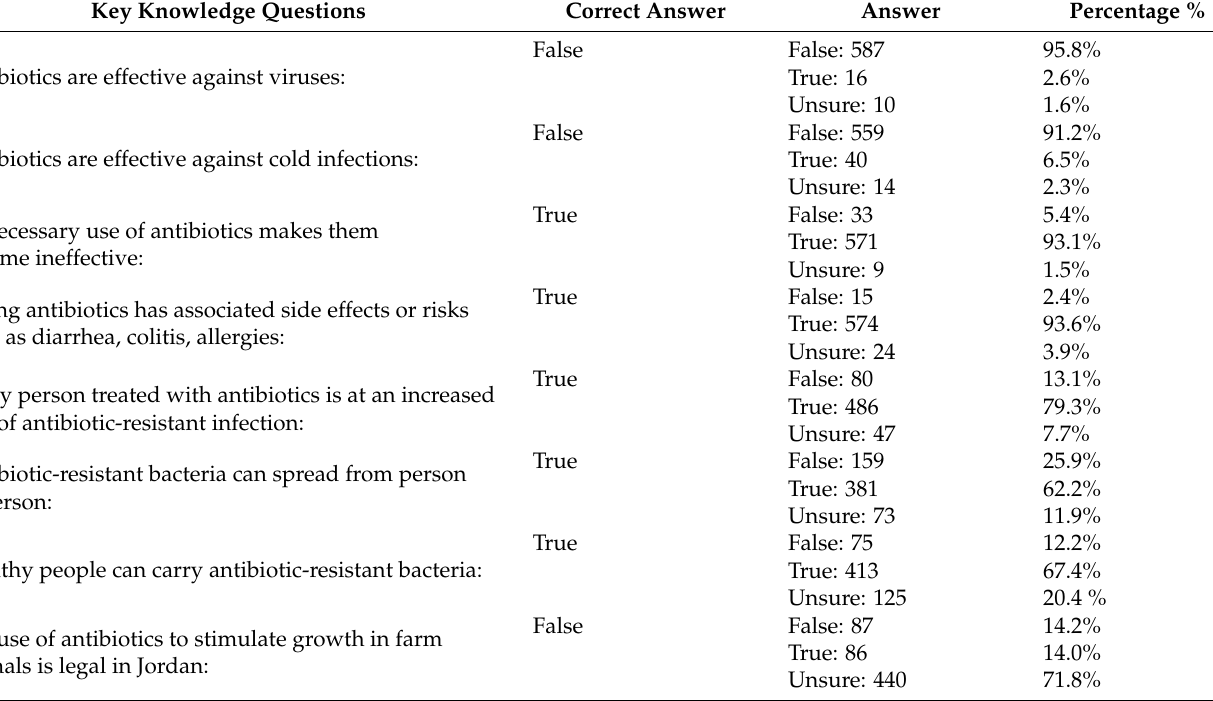
Table 2. Respondents’ actual knowledge.